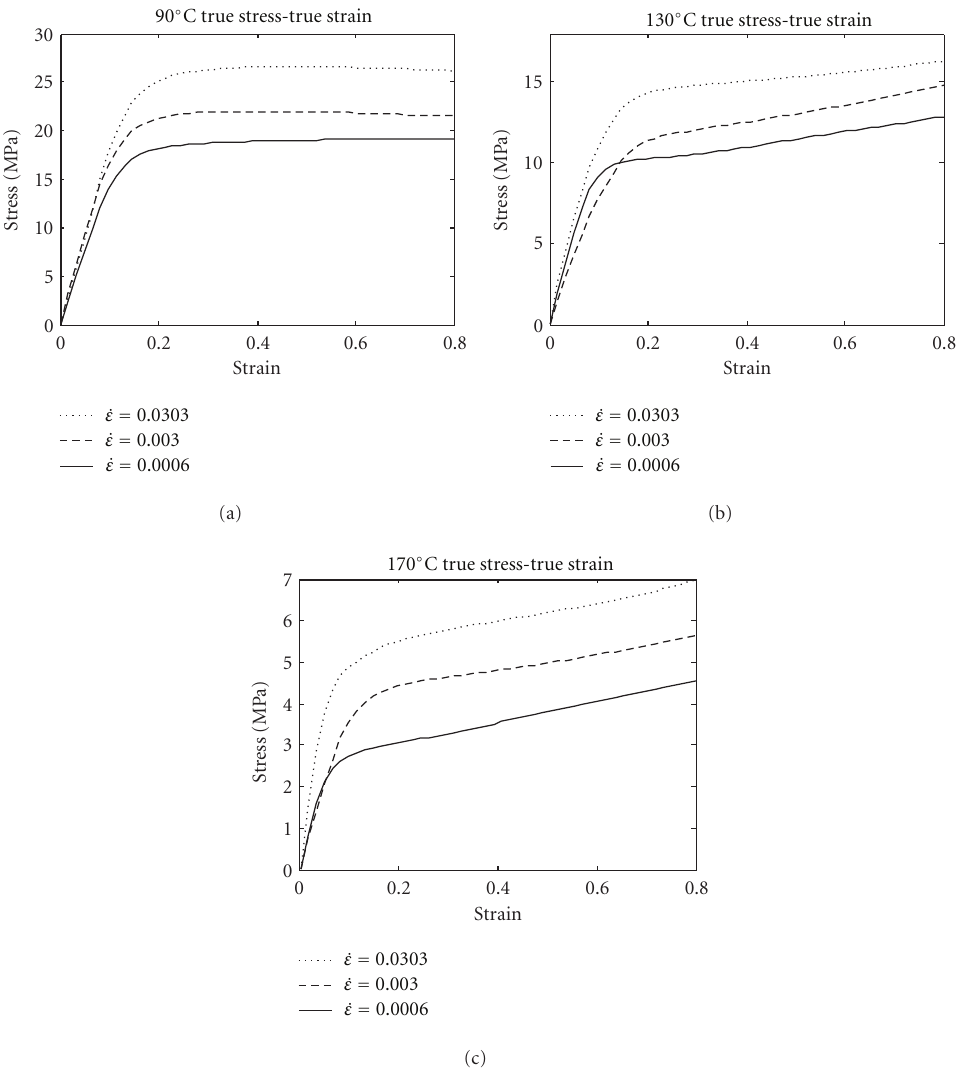
Figure 2: True stress-strain curves under compression with di ff erent strain rate (s − 1 ).